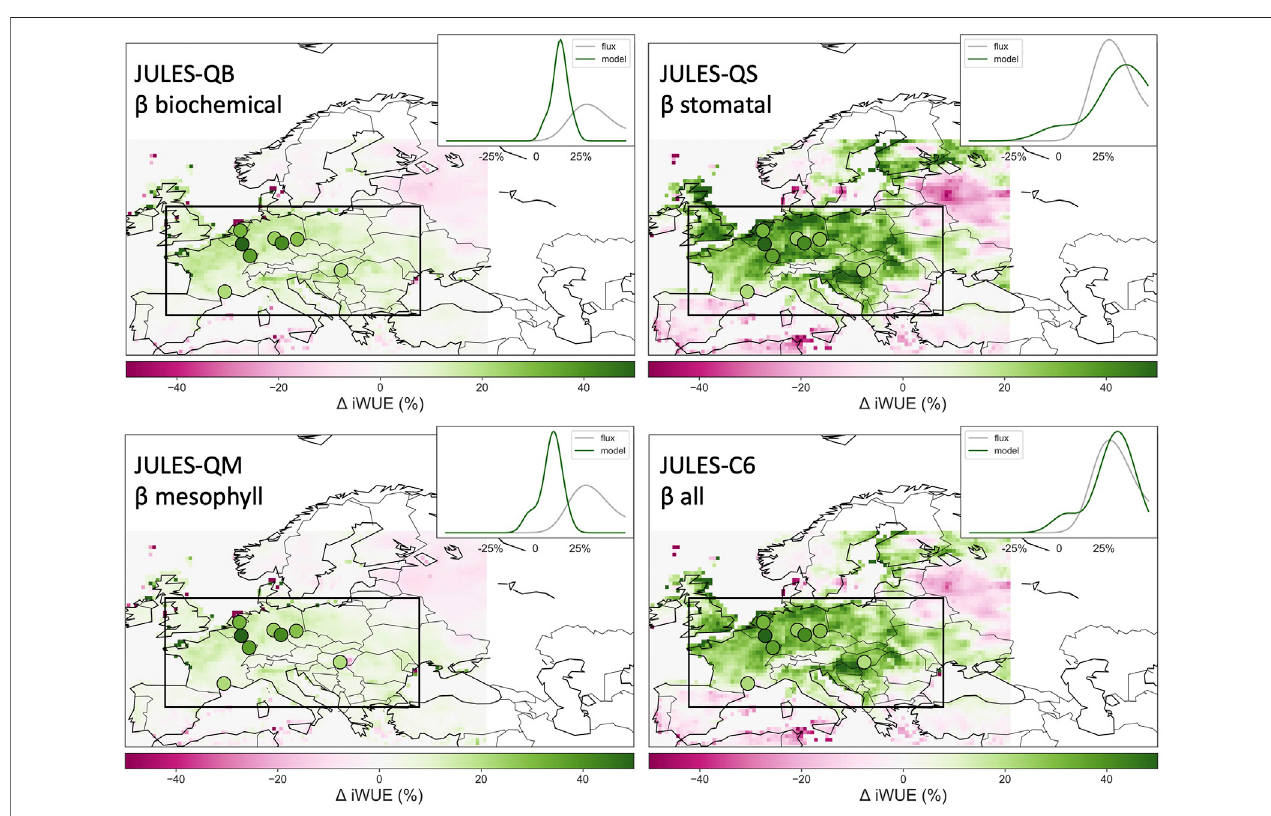
FIGURE15| WaterUseEf fi ciencyanomalyfor2003( Δ iWUE,%),asrevealedbythePetersetal.(2018)datasetandassimulatedbyJULESusingthefourdifferent ß pathways.